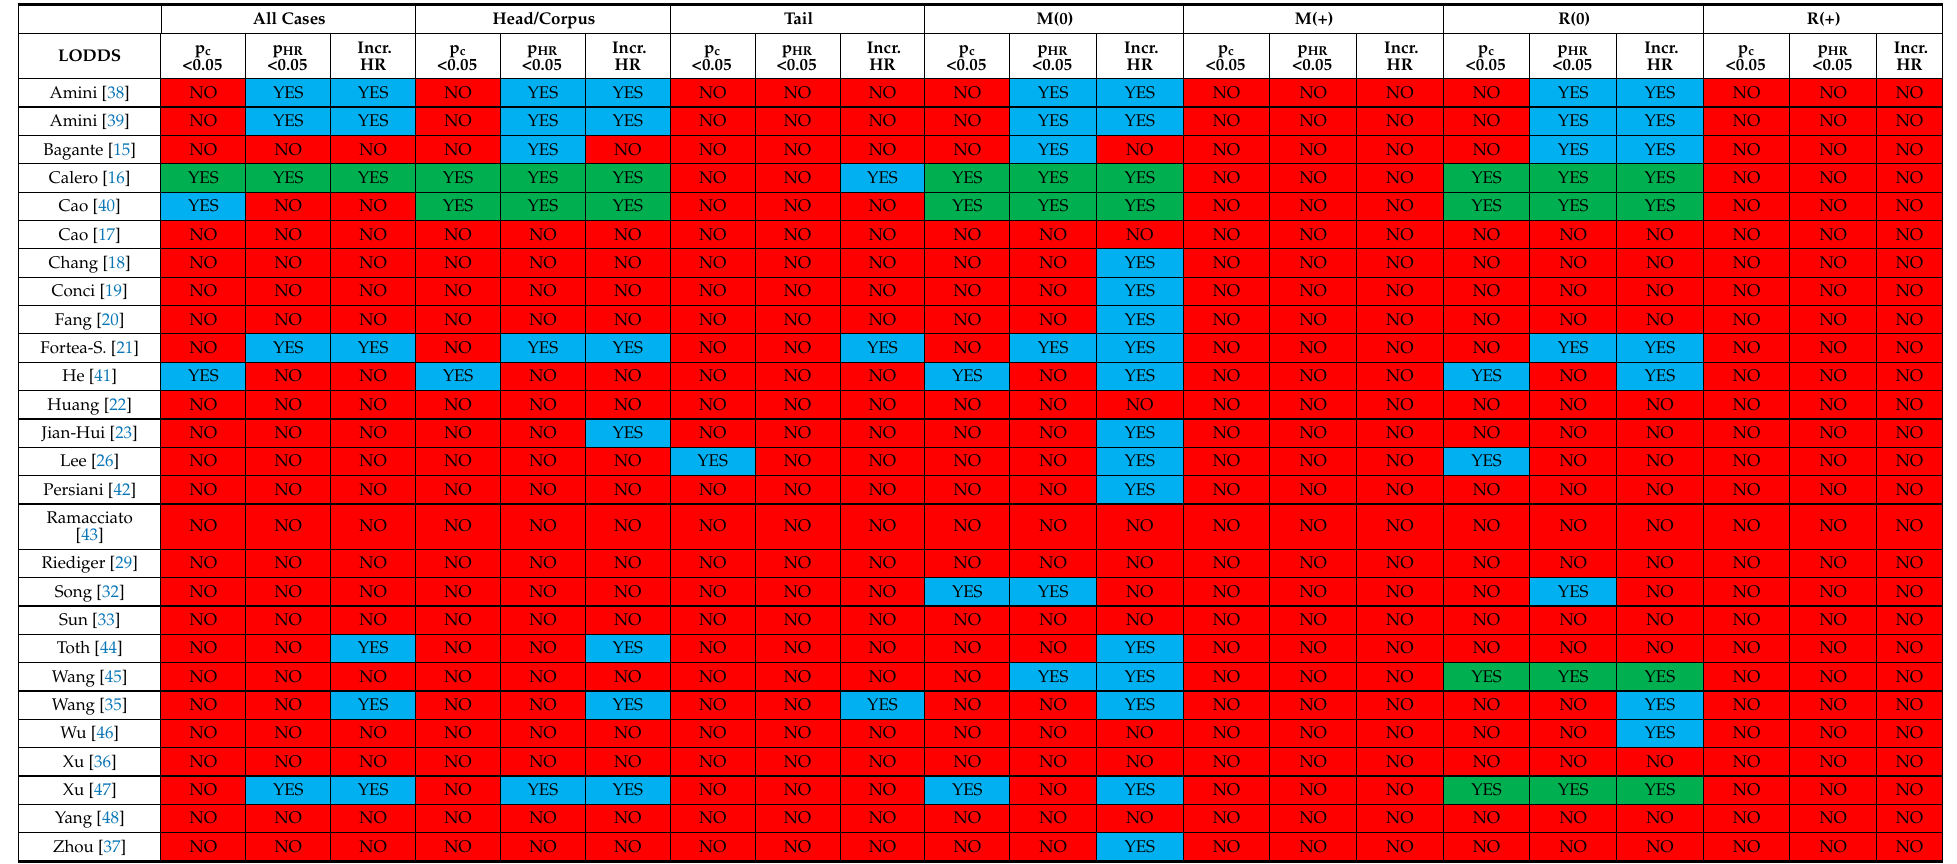
Table 4. Presentation of LODDS classifications and their statistical significance (YES/NO) with regard to C statistic (p c ), Cox regression (p HR ), and ascending values of HRs parallel to the assorted risk groups (Incr. HR) for various patient subgroups. Classifications that satisfy an investigated parameter are marked blue, and classifications that satisfy all three investigated parameters are marked